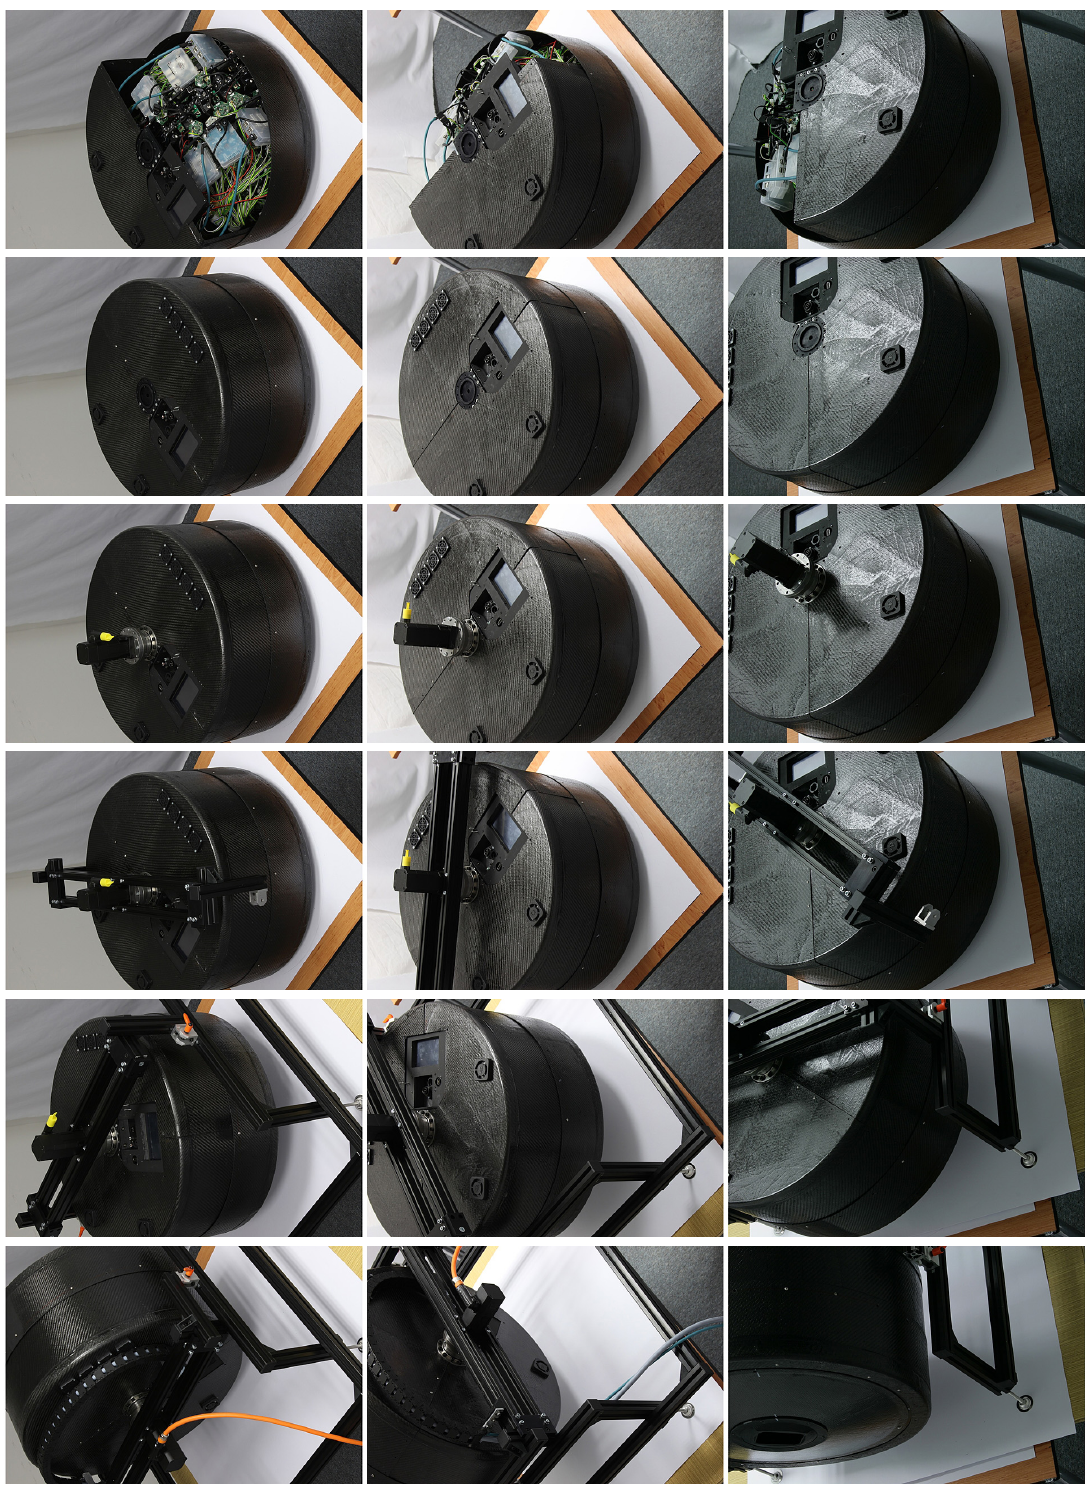
Figure A5. Assembly of lightdrum, step 25 to 30 from three different views. Row 1: mounting the left carbon top cover part; Row 2: mounting the right carbon top cover part and completing the lightdrum; Row 3: mounting the servo motor with gear box to the lightdrum; Row 4: mounting the aluminium profile holder onto the gear box; Row 5: mounting the lightdrum with the aluminium holder onto the holding frame for measurement of floor or on the desk, using two joints; Row 6: showing the same holding frame for measurement setup on the wall close above the